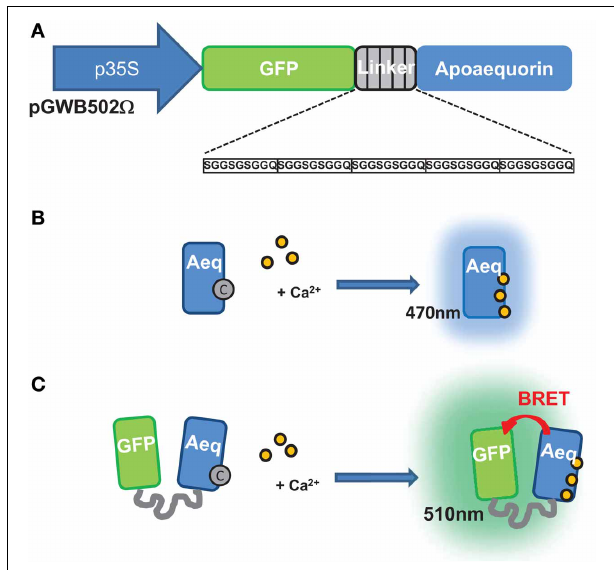
FIGURE 1 | Construction and operating principle of the G5A Ca 2 + reporter. (A) Structure of the chimeric gene encoding the G5A sensor. The open-reading frame ( ORF ) encoding the green fluorescent protein (GFP) is linked to the ORF encoding the apo-aequorin by five repeats of a short sequence encoding a SGGSGSGGQ oligopeptide. The structure and length of this linker ensures efficient bioluminescence resonance energy transfer (BRET) between the aequorin and the GFP (Baubet et al., 2000). Using the pGWB502 (cid:2) vector, constitutive G5A expression is driven by a 35S promoter. (B) Principle of the aequorin bioluminescence emission upon binding of Ca 2 + . In the presence of the coelenterazine cofactor (“C”),